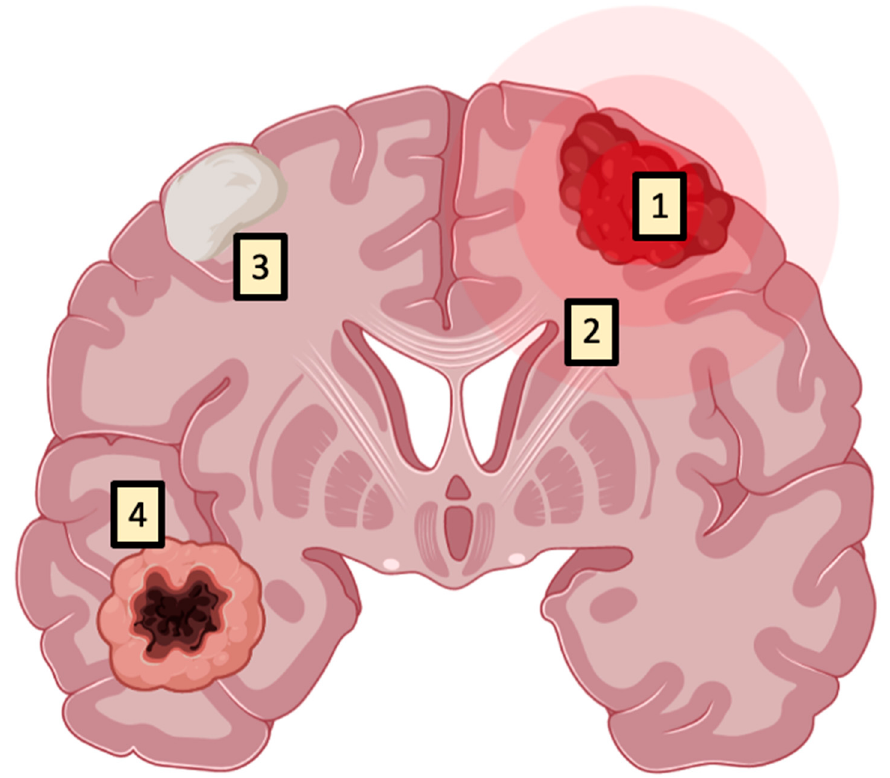
Figure 6. Even if 5-ALA is a highly tumor-specific tracer (1), fluorescence could be observed in normal anatomical structures such as the periventricular area (2) or in conditions or systemic inflammatory pathologies such as multiple sclerosis, brain abscesses (3), and other inflammatory diseases involving the brain, or in cases of radionecrosis (4) due to the presence of inflammatory infiltrates.